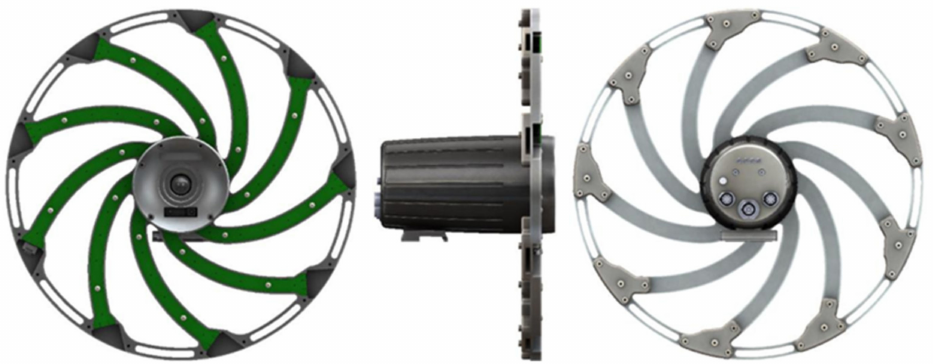
Figure 7. Structural diagram of acoustic